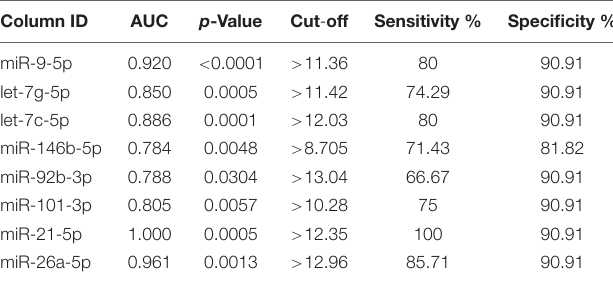
TABLE 2 | Diagnostic efficiencies of serum exosomal miRNA candidates in early-stage gastric cancer. Column